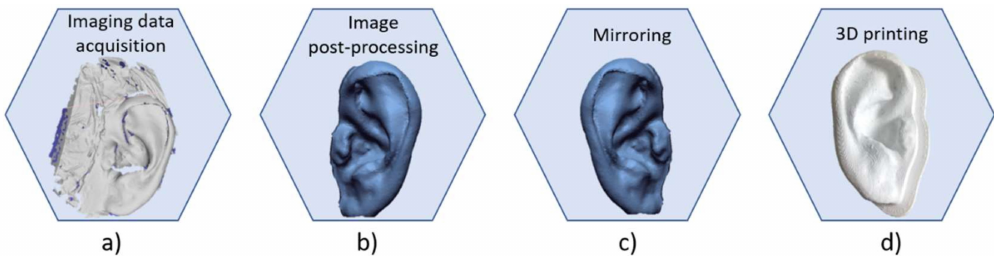
Figure 6. Workflow to produce three-dimensional ear template: ( a ) image data acquisition of the healthy ear; ( b ) image post-processing and digital 3D reconstruction; ( c ) mirroring of the ear; ( d ) 3D printing of the